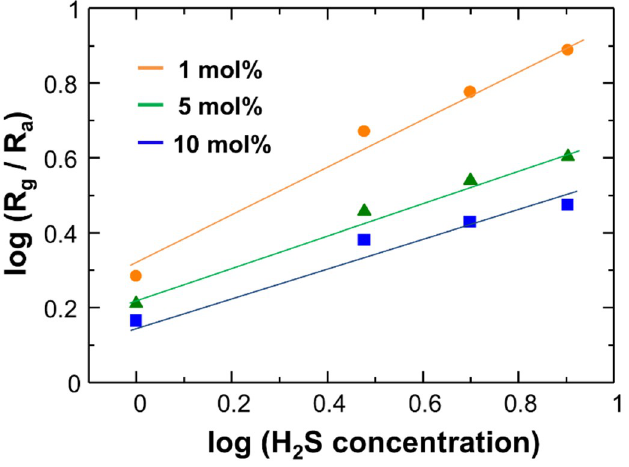
Figure 12. Dependence of sensor response on H 2 S concentration for the Pd (1, 5, 10 mol%)-loaded CuO NC sensors operated at 250 °C.